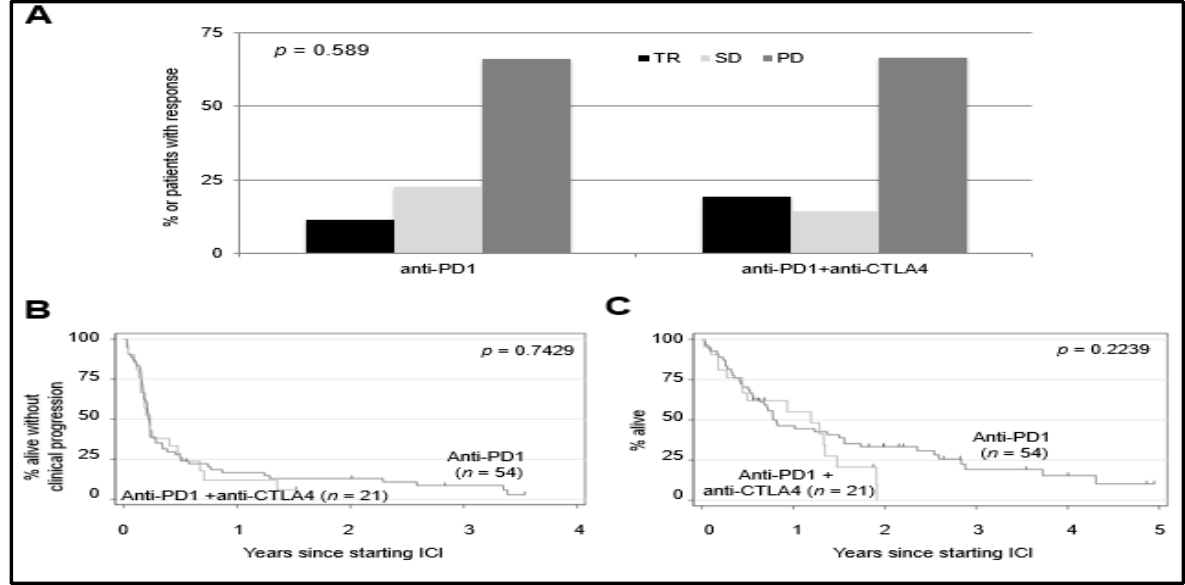
Figure 2. Treatment response and survival outcomes according to anti-PD1 regimen. ( A )Treatment response according to whether patients received anti-PD1 monotherapy ( n = 54) or anti-PD1 + anti-CTLA4 ( n = 21). TR = tumor response, SD = stable disease, PD = progressive disease. The difference in the distribution of treatment responses according to ICI regimen type was assessed with a Fisher’s exact test ( p = 0.589). ( B ) Clinical progression-free survival and ( C ) overall survival according to anti-PD1 ICI regimen. Log-rank test p = 0.7429 (cPFS); p = 0.2239 (OS). Tick marks indicate censored patients.